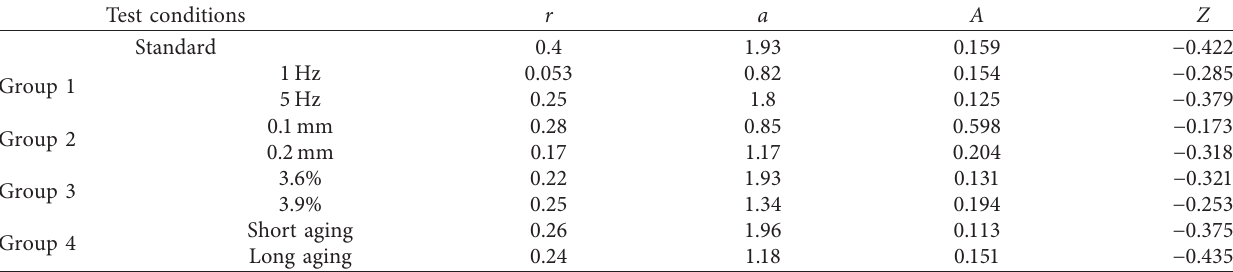
Table 4: The calculation parameters.